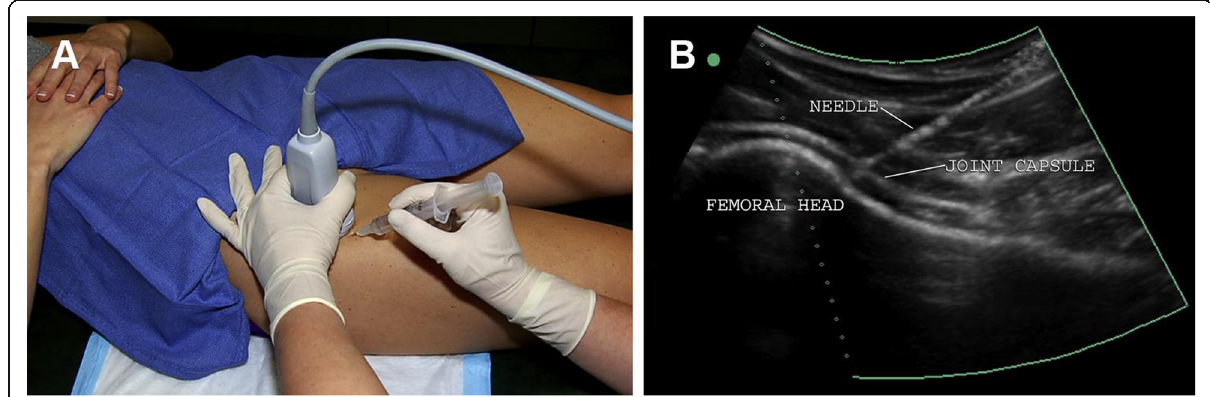
Fig. 1 a The needle is inserted in plane with the transducer, which allows visualization of the needle throughout the course of its advancement to the capsule. b The needle can be seen entering the right hip joint capsule at the femoral head – neck